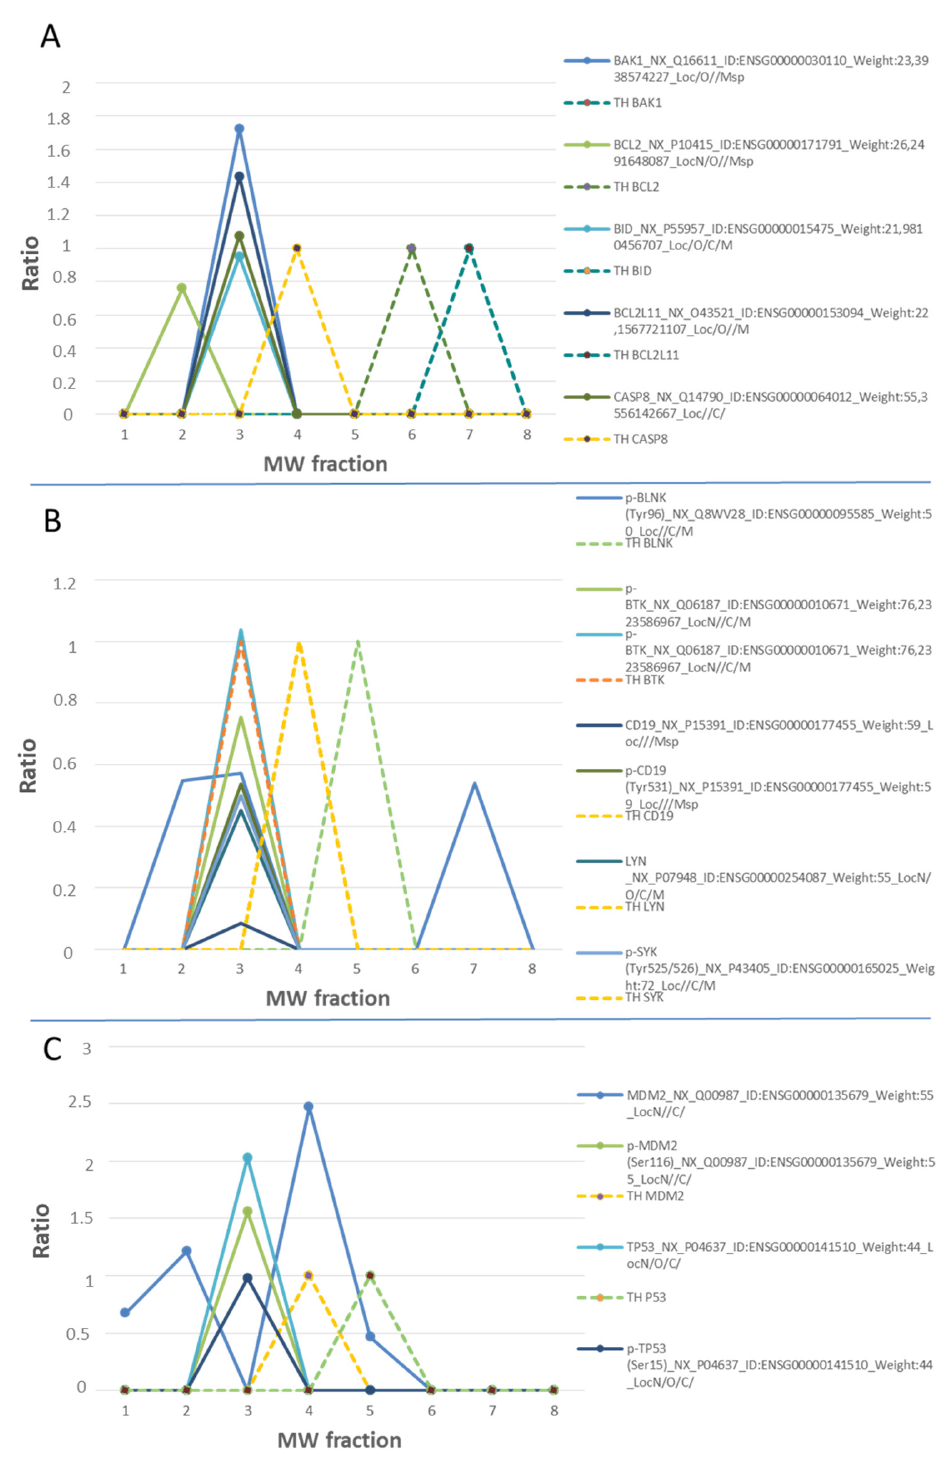
Figure 4. Multicomplex protein analysis by the SEC-MAP approach. Multiprotein complexes were detected at different protein extraction procedures. Peaks located at the same molecular weight (MW) fraction, and not found in their theoretical (TH) MW fraction, represent complexes formed by proteins when they are at a fraction above the expected one. When it is found in fractions below those expected, we speak of protein being hydrolyzed. If it is detected in theoretical fraction (dotted line), protein is found alone. ( A ). Proteins related to the BCL-2-BCL2L11 interaction signaling pathway. ( B ). Proteins related to the BTK pathway. ( C ). MDM2-TP53 interaction.